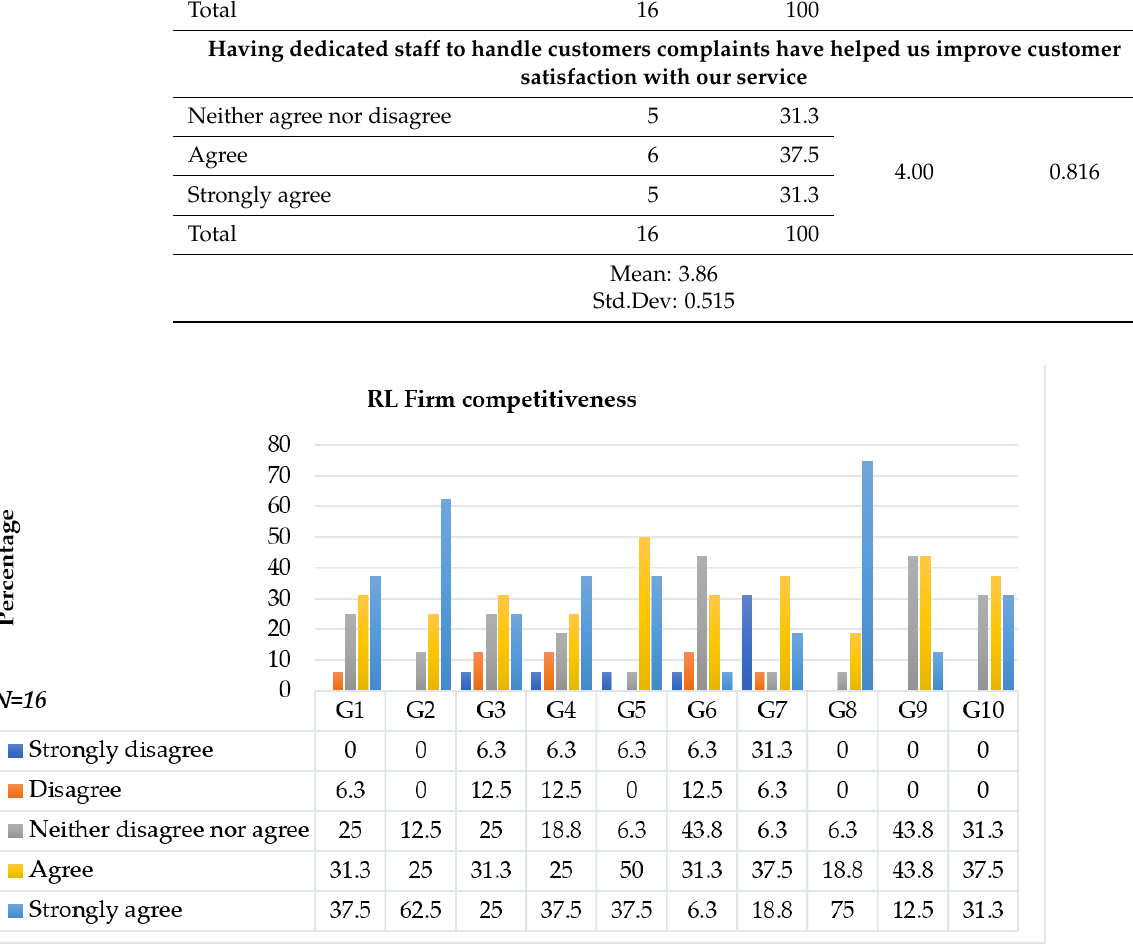
Figure 3. RL firms’ competitiveness based on retailers. G1 = Our FMCG retail firm is more profitable compared to our competitors; G2 = Our FMCG retail firm provides products of higher quality as compared to our competitors; G3 = Our FMCG retail firm offers products of lower cost as compared to our competitors; G4 = Recycling waste has enabled our FMCG retail firm to offer products of better value than that of our competitors; G5 = Dumping waste in a legally controlled and safe ground has helped us to protect our image; G6 = Reusing our expired products that are safe for use has made us gain a low-cost advantage over our competitors; G7 = Changing the packaging of returned damaged products and selling them to second-hand markets has helped us improve our product image; G8 = Having a product returns policy has helped us to improve our image in the market; G9 = Having a separate unit that deals with the returned products has helped us improve our service to our customers; G10 = Having dedicated staff to handle customers complaints has helped us improve customer satisfaction with our